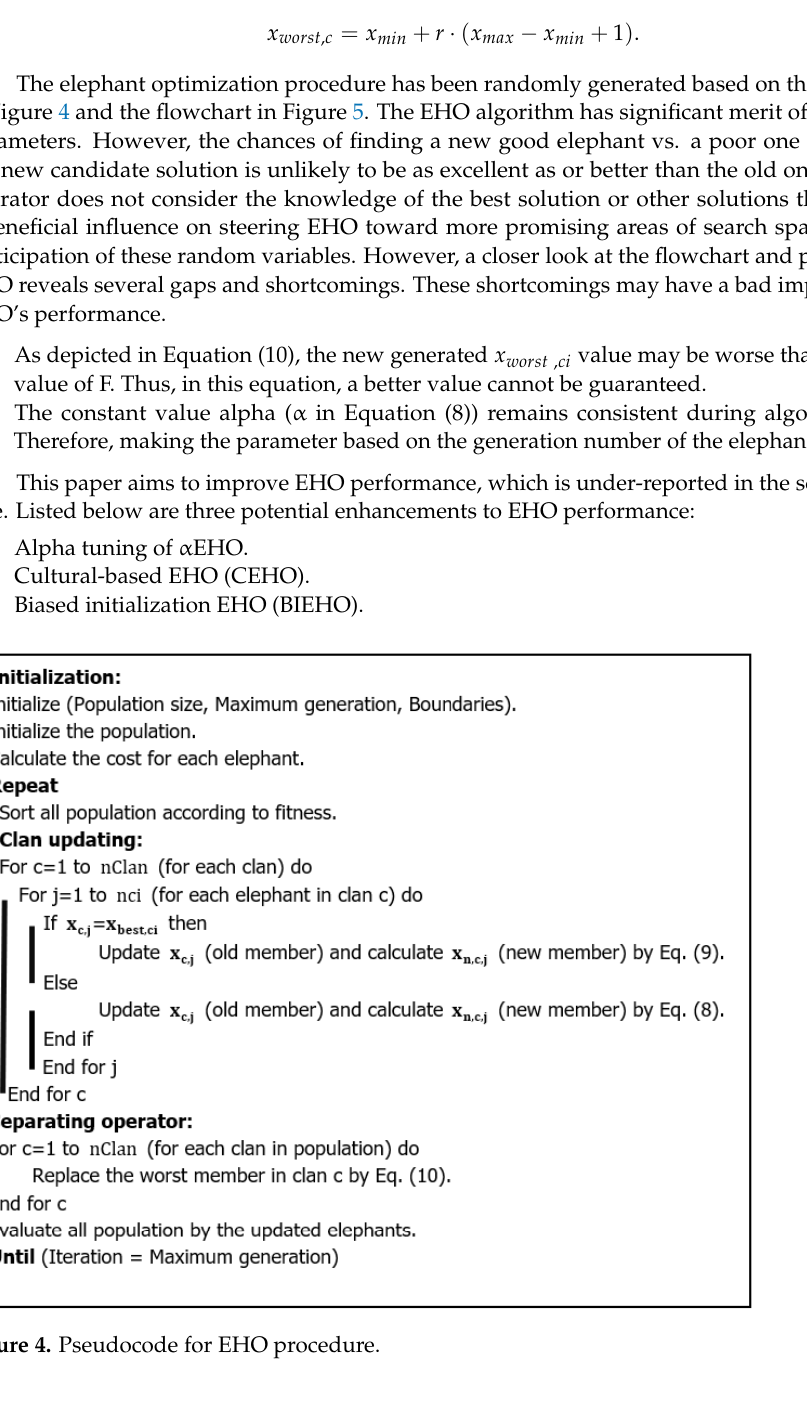
Figure 5. Flowchart of EHO. 3.1. Alpha Tuning of αEHO Careful investigation of EHO parameters recommends setting the scale factor 𝛼 to be adaptive is more promising than being a constant value in the range [0, 1]. Putting it simply, making alpha adaptive and related to the population number is more convenient and matched to the notion of evolution in Equation (11). In the original